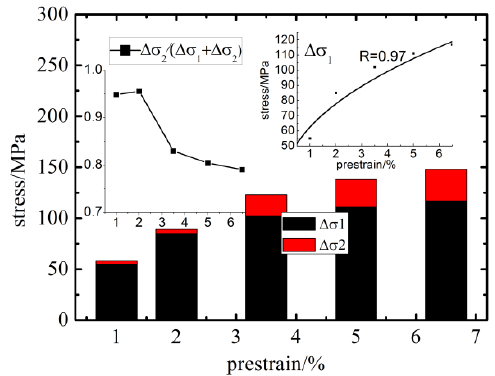
Figure 11. The quantified analysis of effects of dislocations associated mechanisms (Δσ 1 ) and other mechanisms (Δσ 2 ) on strain hardening.